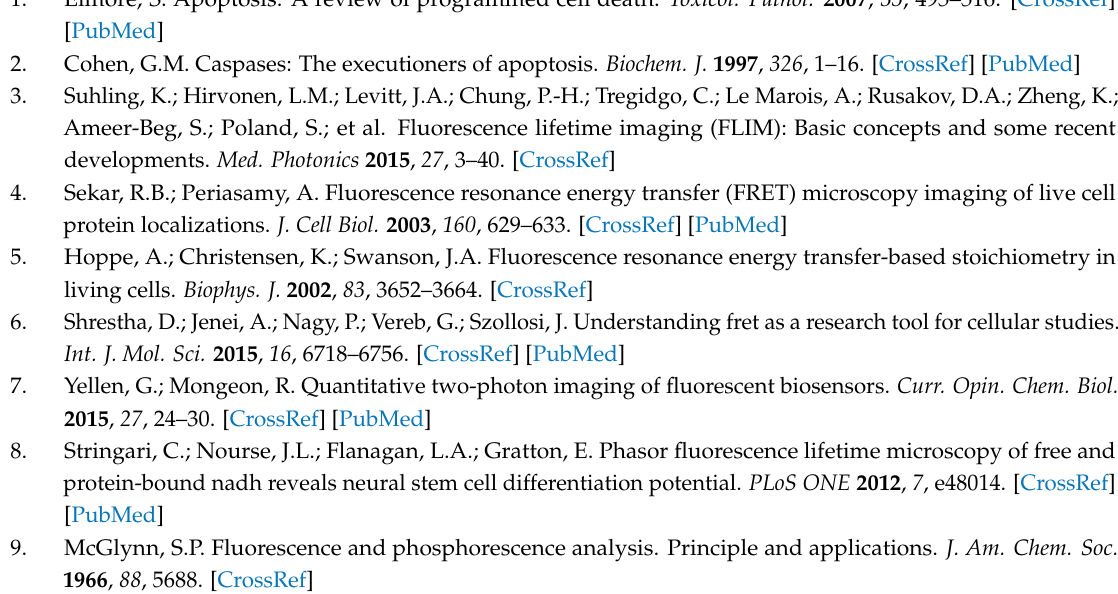
Figure 2. MDA-MB-231 cells show increased apoptosis with nutrient starvation. Left. MDA-MB-231 cells that have been starved of both glutamine and glucose ( bottom ) show a higher proportion of red pixels (indicating apoptosis) than the control, nutrient-rich condition ( top ). Right . The phasor plot indicates the ROIs that were selected. The numbers below the phasor plot indicate ROI spatial information. Points nearest the origin on the x -axis have a longer lifetime. The orange ROI indicates pixels with a shorter lifetime (no caspase-3 activity, FRET is occurring) and the red ROI indicates pixels with a longer lifetime (caspase-3 activity and apoptosis, no